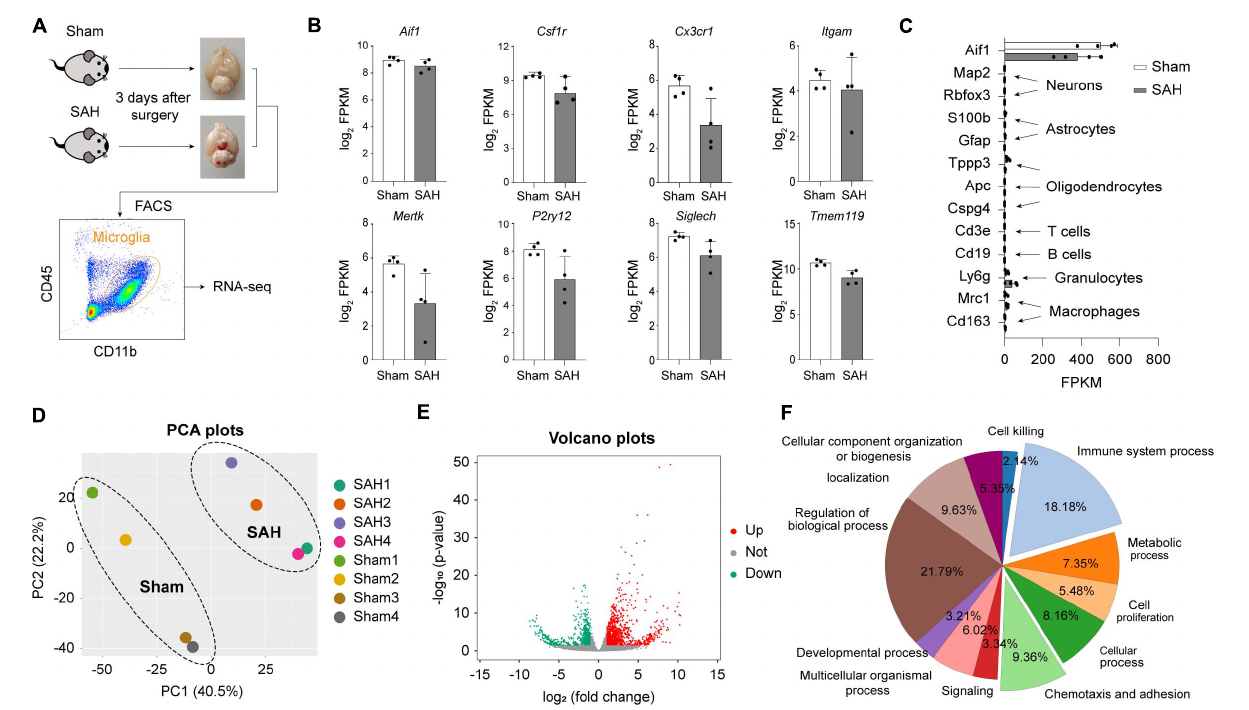
FIGURE 2 | Subarachnoid hemorrhage induces strong transcriptomic alterations in microglia. (A) Microglia cell sorting strategy. (B) mRNA expression levels of microglia marker genes. (C) mRNA expression levels of microglia ( Aif1 ), neuron ( Map2, Rabfox3 ), astrocyte ( S100b , Gfap ), ependymal cell ( Tppp3 ), oligodendrocyte progenitor cells ( Apc , Cspg4 ), T cell ( Cd3e ), B cell ( Cd19 ), neutrophil ( Ly6g ), macrophage ( Mrc1 , Cd163 ), and marker genes. (D) PCA plots of microglia transcriptome sequencing results. (E) Volcano plots show the DEGs (fold change > 2 or < –2, adj_pval < 0.01) in microglia from SAH brain versus sham brain. (F) Shown are the percentages of significantly overrepresented GO terms. Twelve major clusters of functions were identified.